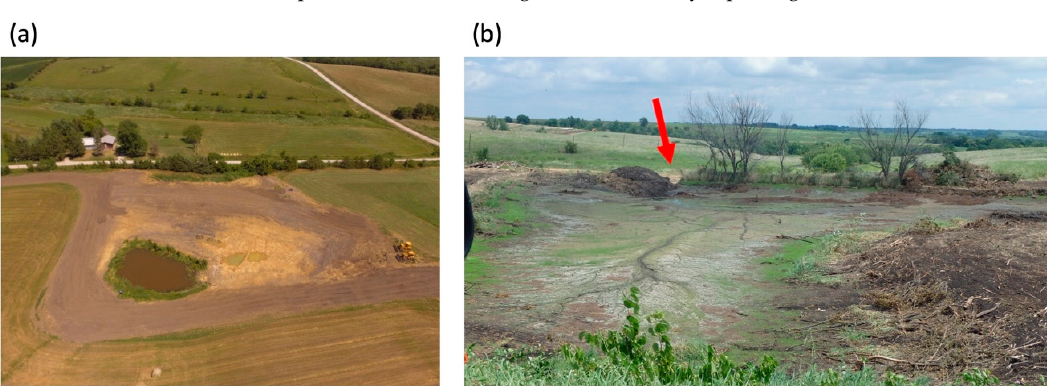
Figure 3. Photographs illustrating possible renovation processes for a pond on parcels where: ( a ) the lack of suitable sites on the property means that a new pond will be built around an old pond, which will be flooded when the new pond is complete; or ( b ) the embankment of the pond is breeched (red arrow) and the pond is drained, allowed to dry, and will later be dredged. In both cases, the shallow-water ecosystem that developed over time will be destroyed and replaced by a deep, permanent water pond